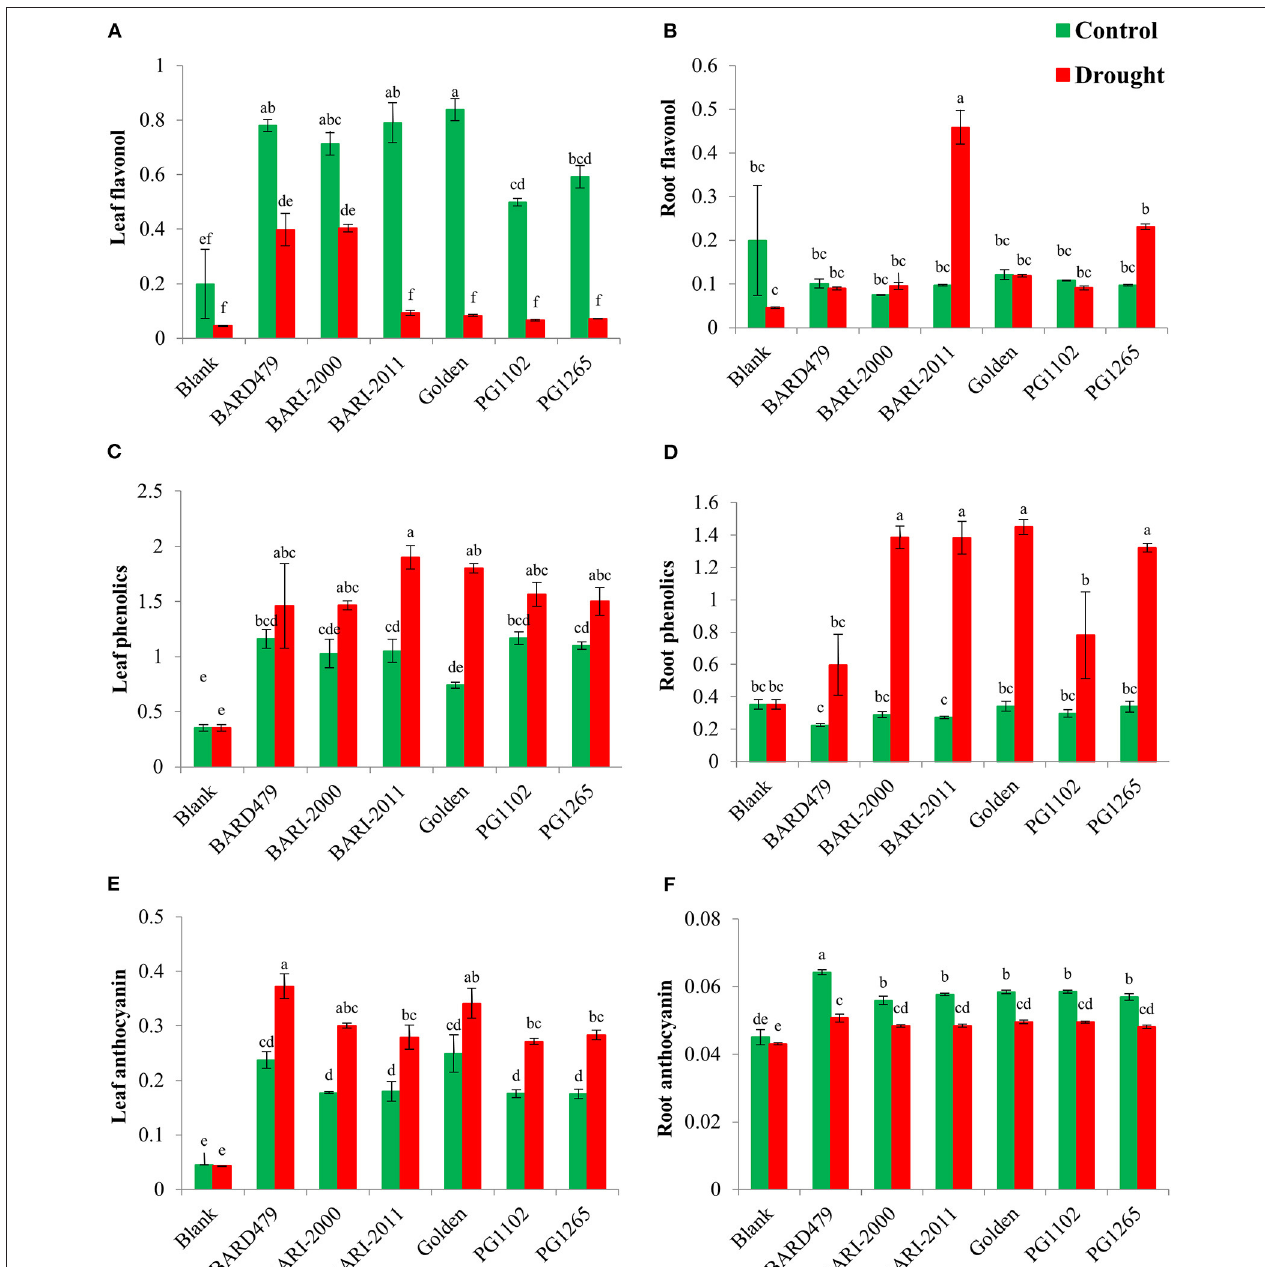
FIGURE 1 | Metabolites content accumulation in peanut genotypes under drought stress. The panel shows the following: the leaf flavonol (A) , the root flavonol (B) , the leaf phenolics (C) , the root phenolics (D) , the leaf anthocyanin (E) , and the root anthocyanin (F) . Data are shown as the interaction between the genotypes of peanuts and the drought applied. Significance was inferred either with an ANOVA under the Tukey’s HSD post-hoc test for normally distributed data (Honest Significant Detection, p < 0.05). Non-parametric data were analyzed with a Kruskal–Wallis test under False Discovery Rate post-hoc correction (FDR, p <